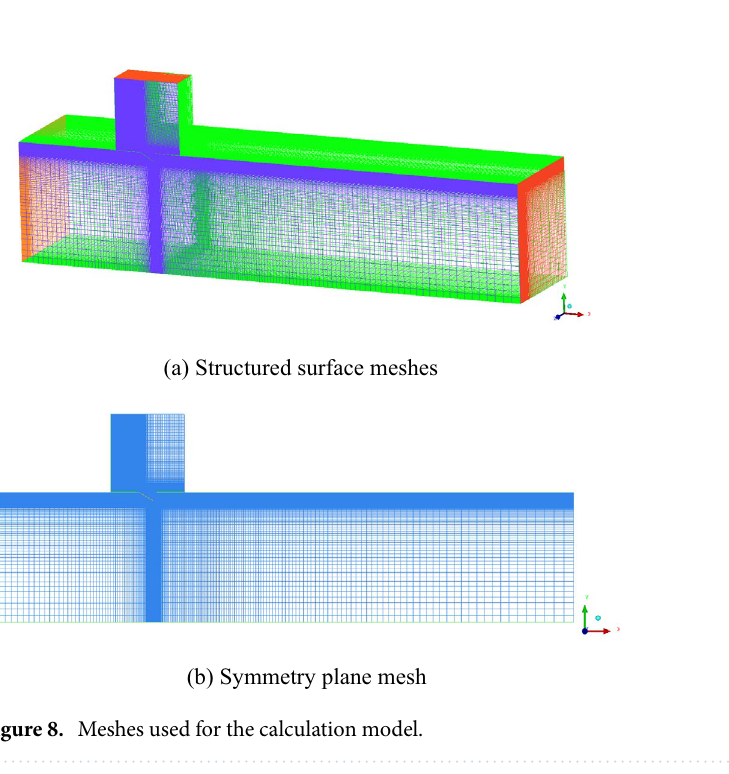
Figure 7. Physical model.